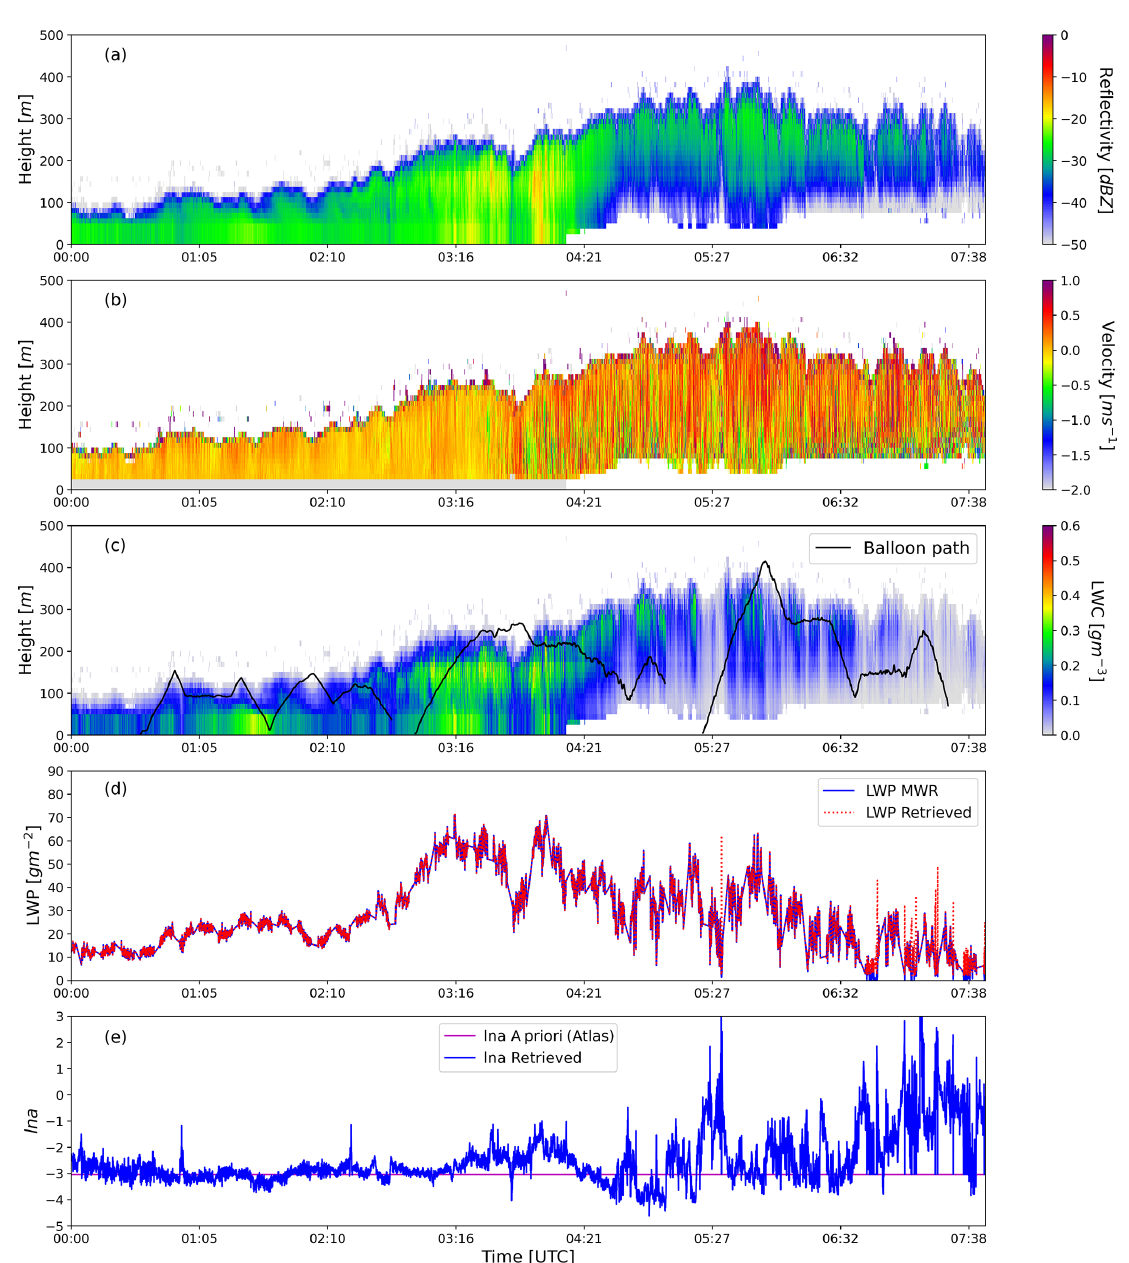
Figure 6. (a) Radar reflectivity Z extended to the lowest gates, (b) Doppler velocity plotted only for the available gates, (c) retrieved LWC, (d) LWP, and (e) retrieved ln a for the 9 February 2020 case at the SOFOG-3D super-site. The tethered balloon trajectory over retrieved LWC is shown by the black